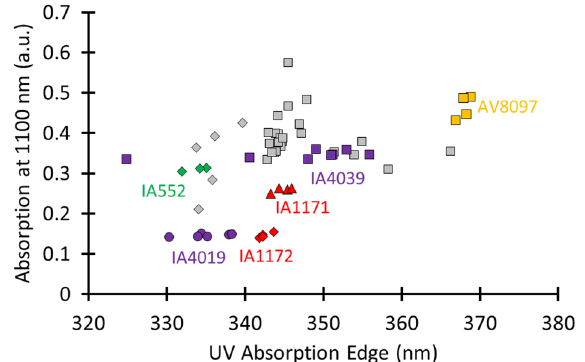
Figure 8. Plotting the UVAE values against the absorption values at 1100 nm confirms the purer character of the earlier material. The same legend code as in Fig. 7 was applied.